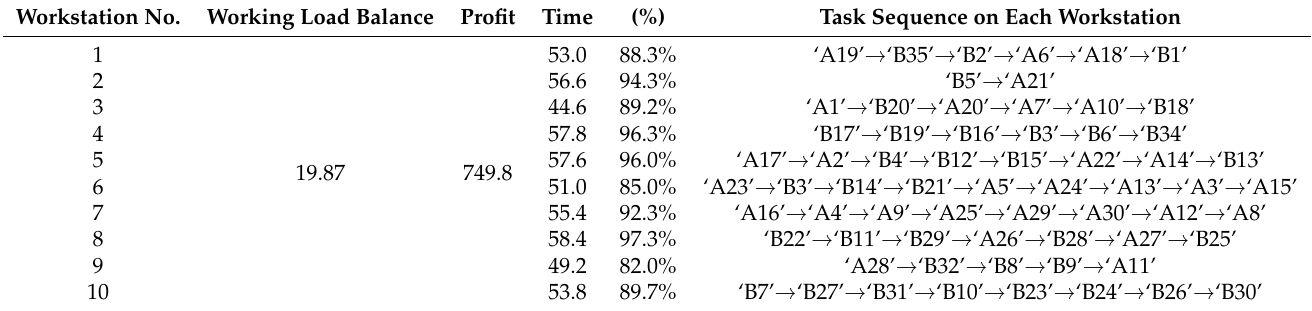
Table 11. One optimal sequence of the disassembly process ( CT 1 = CT 2 = 60). Workstation No.